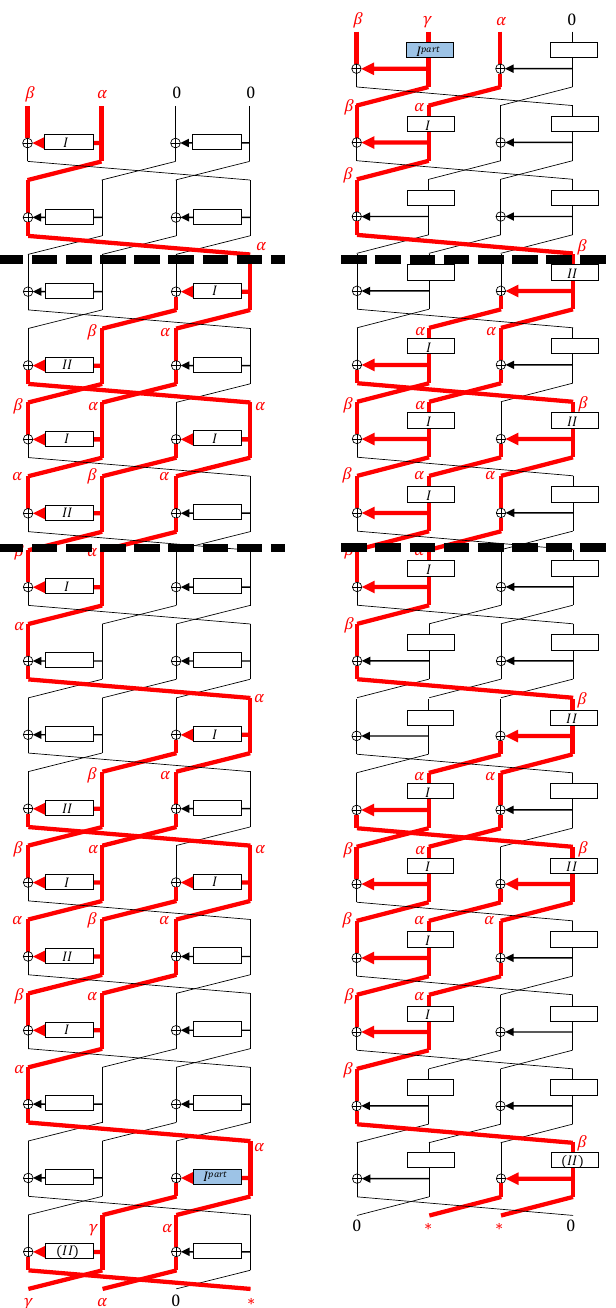
Figure 10: Left: 16-Step Distinguisher for sLiSCP with the Last Step Extended. Right: Extended 16-Step Distinguisher for sLiSCP-light with the First Step Extended. Both contain 1 partially controlled active Simeck box denoted by ‘ I part